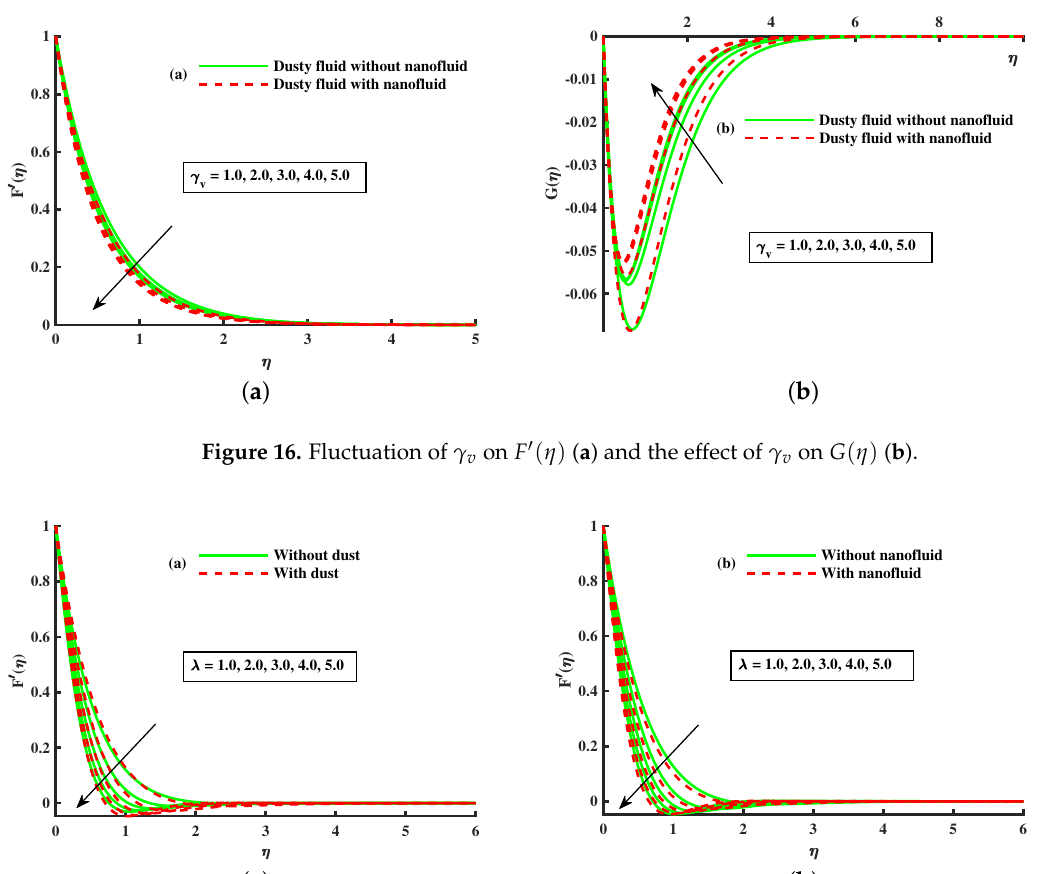
Figure 15. Fluctuation of β m and D m on θ ( η ) ( a ) and the effect of β m and D m on θ p ( η ) ( b ).